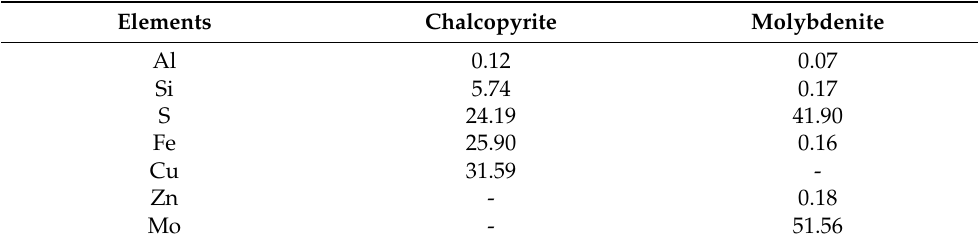
Table 1. Chemical compositions of chalcopyrite and molybdenite measured by XRF (%).